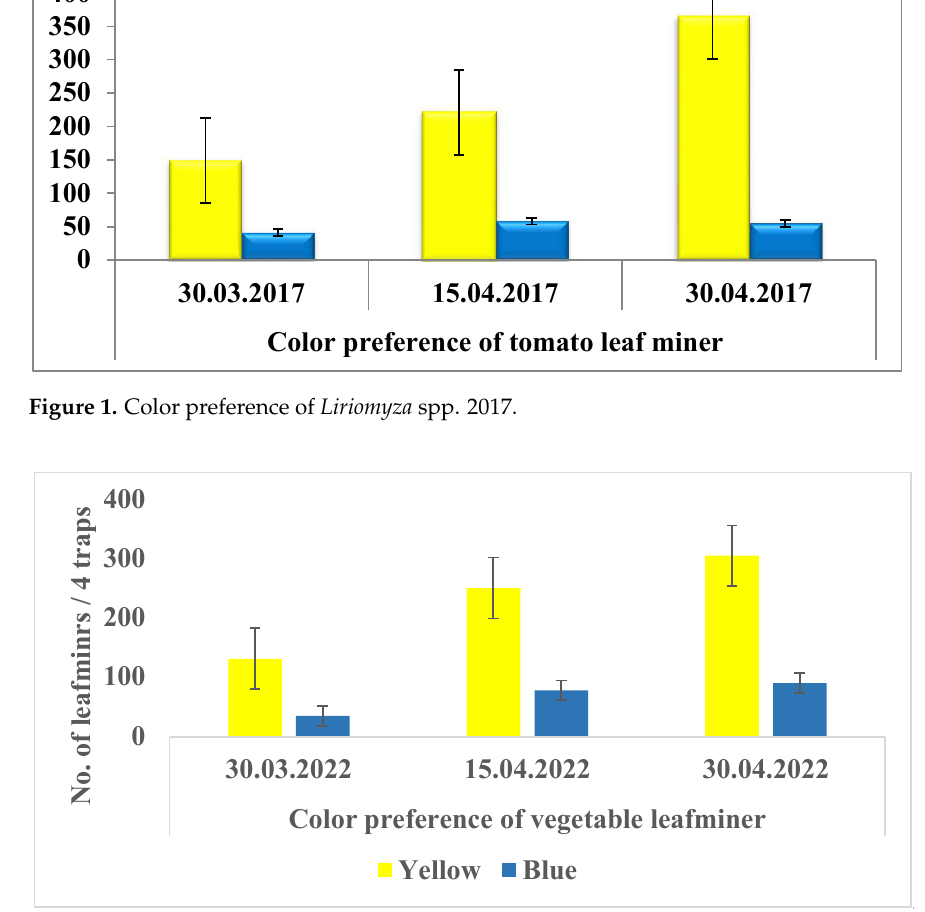
Table 4. Percent infestation of Liriomyza spp. on tomato cultivars.